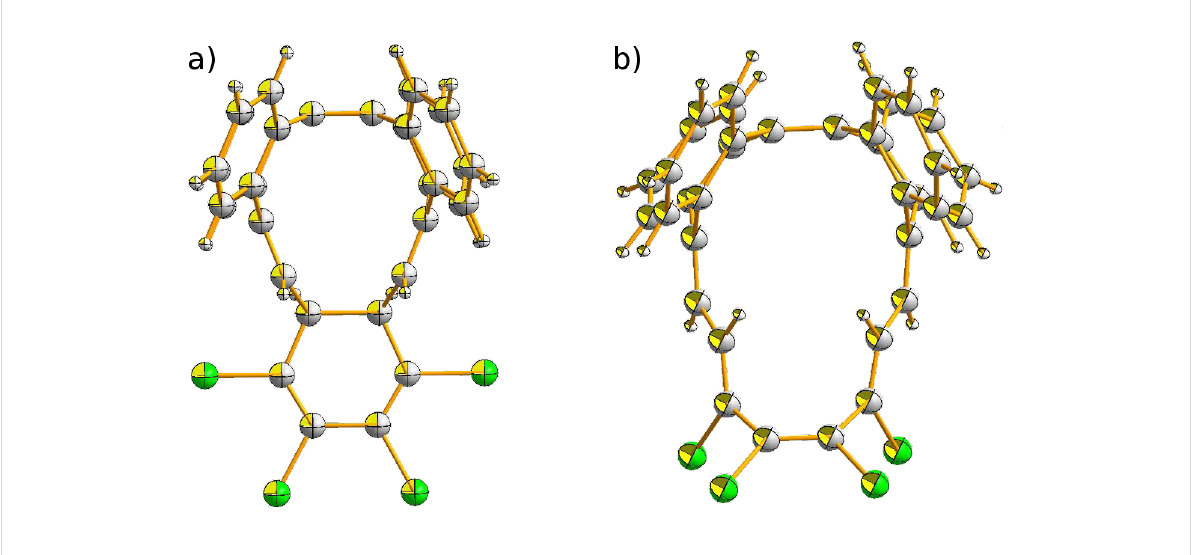
Compound 6 is formally a [16]annulene and therefore should be antiaromatic. However, the olefinic cis double bond forms dihedral angles of 69° and 79° (X-ray) with the two neigh- boring trans double bonds, and thus is twisted out of conjuga- tion. Therefore, its antiaromatic character should be very small.